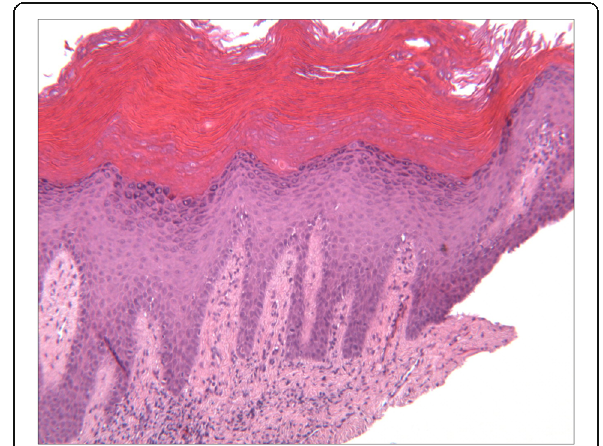
Fig. 2 Severe verrucous hyperkeratosis with elongation of dermic ridges and mild chronic inflammatory infiltrate in the underlying stroma (H&E, 100